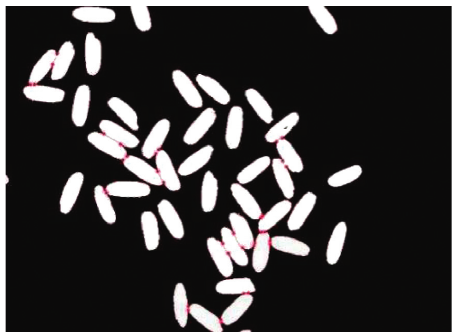
Figure 27: The proposed